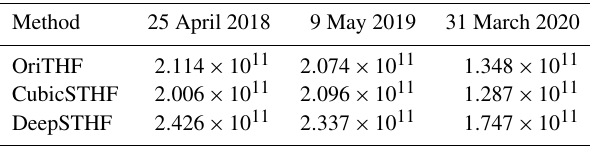
Table 4. Total THF estimated by the three methods on different dates (unit: